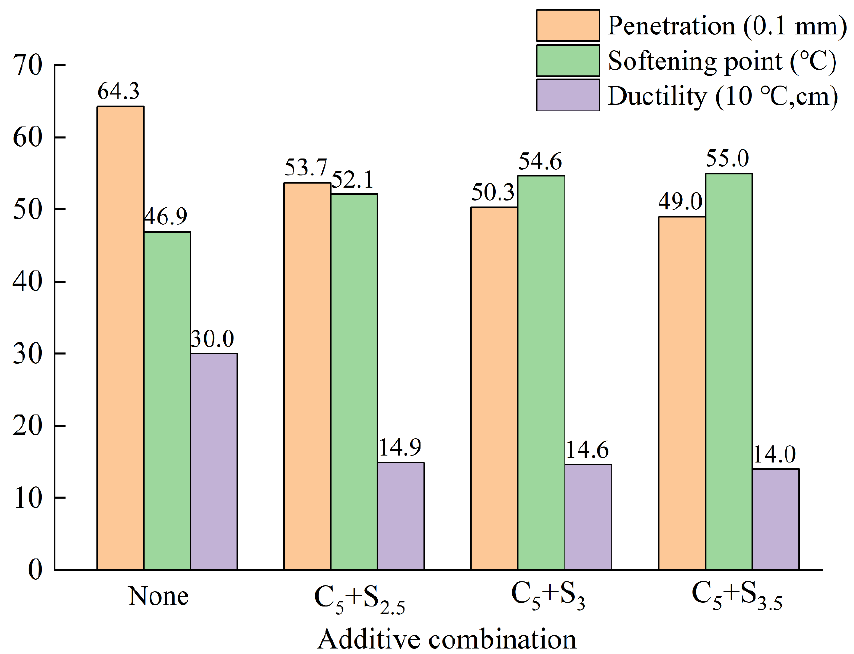
Figure 13. The changing law of the three indexes of asphalt with the different amount of surfactant.